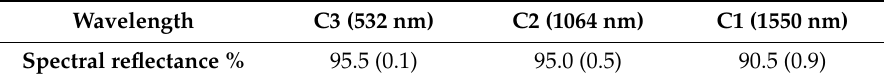
Table 3. Values of spectral reflectance for wavelengths corresponding to Titan measured by ASD (20 samples). RMSE values in